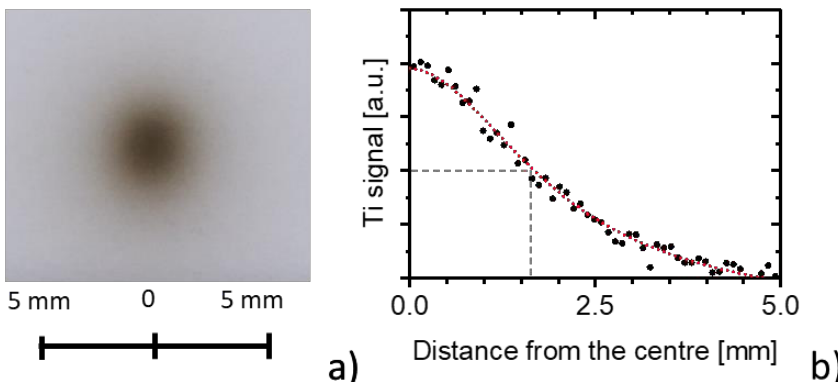
Figure 2. ( a ) Image of the spot of deposited Ti nanoparticles and ( b ) profile of Ti signal on the deposited spot as measured by EDS. The deposition time was 1 min.